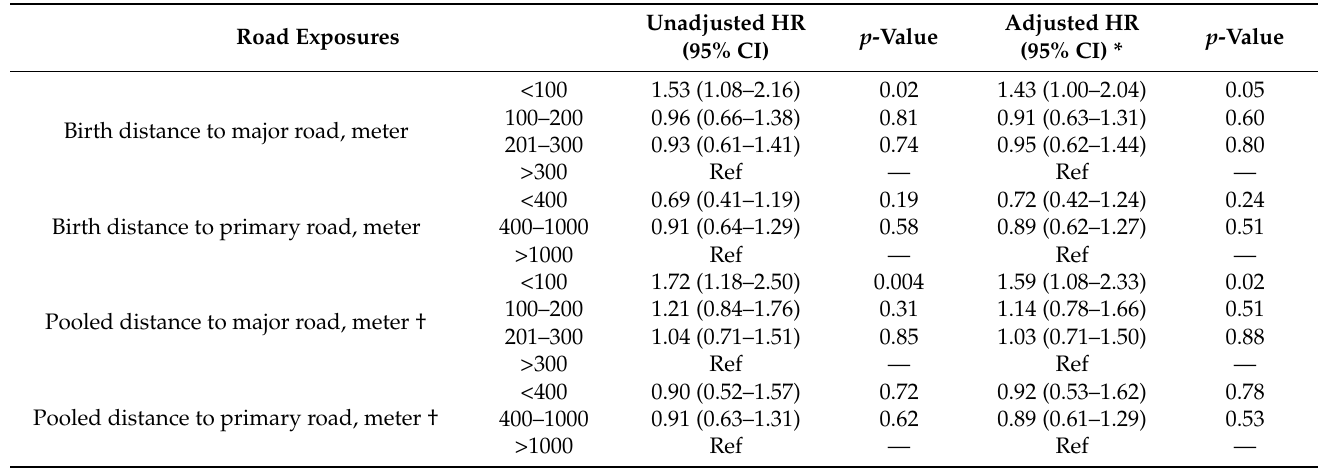
Abbreviations: HR = hazard ratio; CI = confidence interval; Ref = reference category. * Adjusted for age at enrollment (dichotomized by age 2 months), race/ethnicity, health insurance type, preterm birth (with cut-off at 37 months), median household income estimated by ZIP code at enrollment, parental history of asthma, population density of residential area at birth, and infant tobacco exposure at enrollment, and was stratified by sex. † Pooled estimates derived by weighting exposures according to duration spent each address up to age three or time outcome occurred, whichever happened